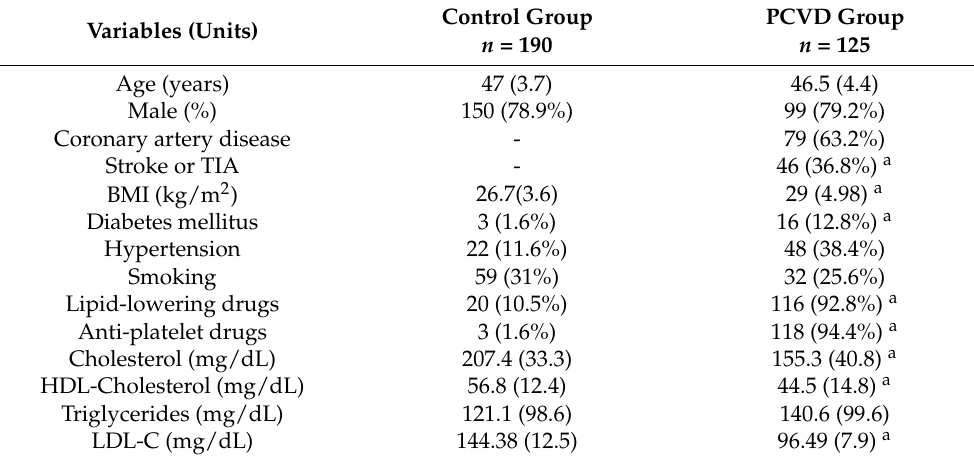
Table 1. Clinical data of patients and control subjects. Variables